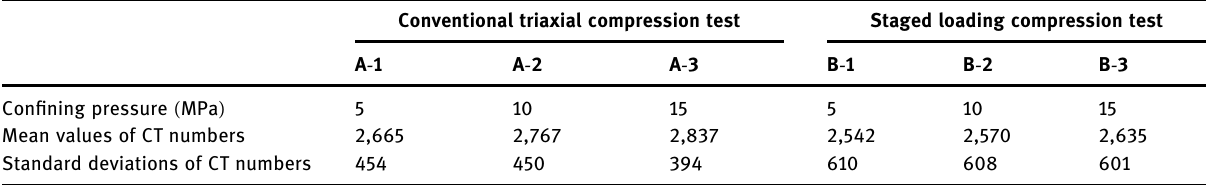
Table 1: Weibull distribution characteristics of the CT number of di ff erent rock samples Conventional triaxial compression test